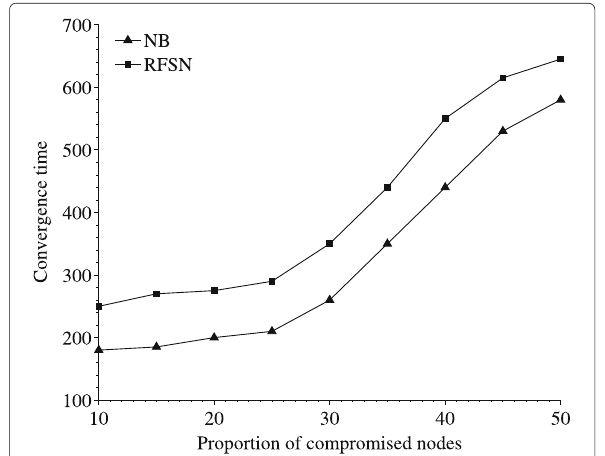
Fig. 6 Convergence time to detect compromised